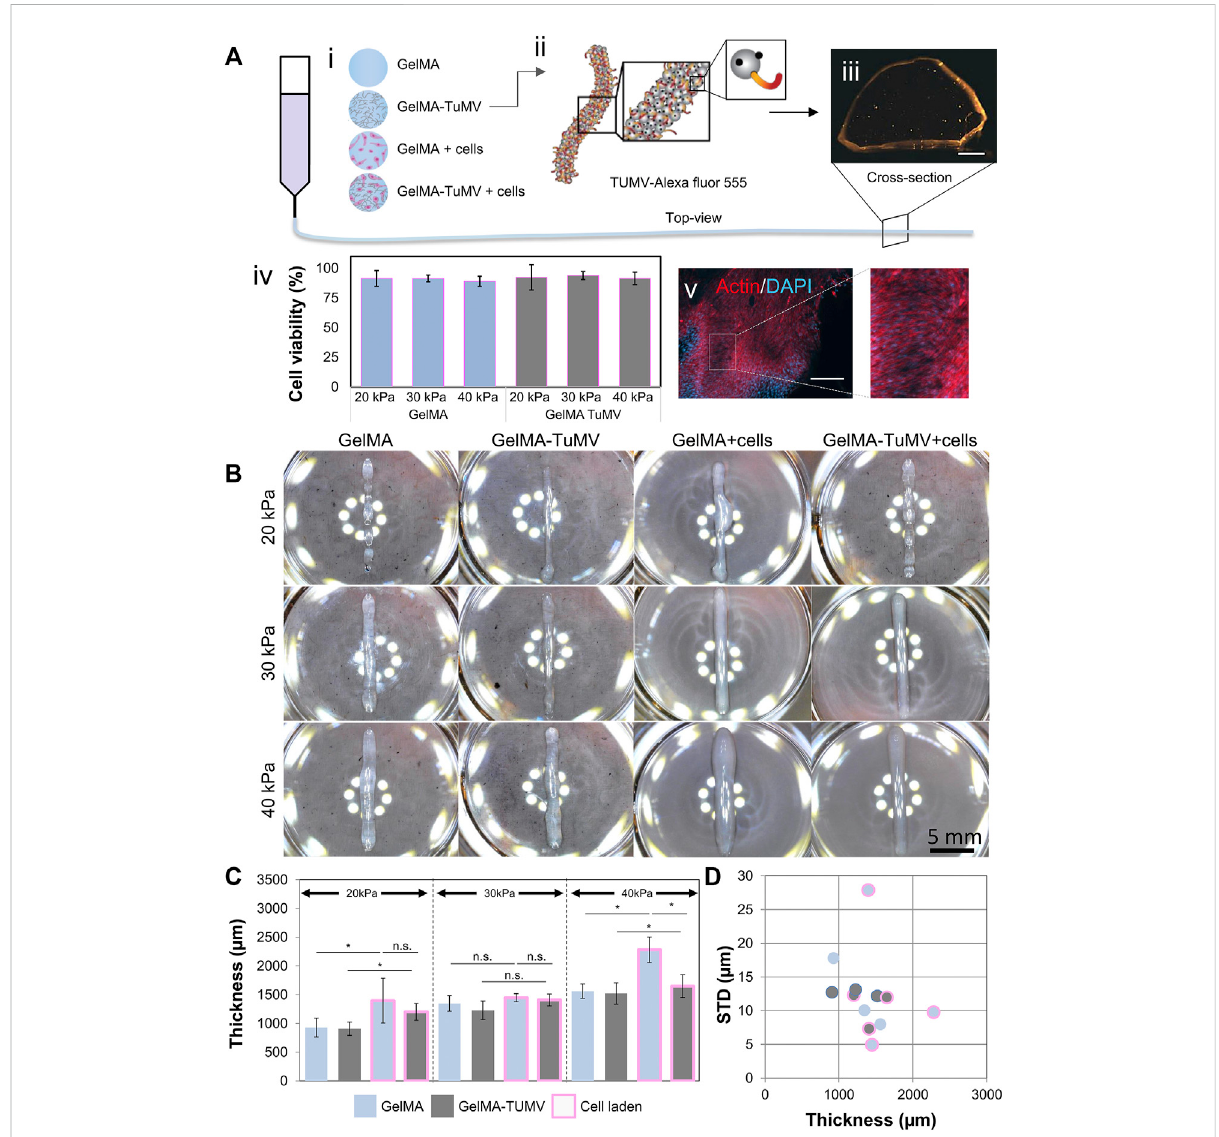
FIGURE 5 GelMA-TuMV bioprinting. (A) Hydrogels tested for extrusion bioprinting. (i) Schematic representation showing the composition of the hydrogels. (ii) Schematic representation ofthe functionalization of TuMV with Alexa Fluor 555and (iii) amicrographof thecross section ofa fi lament printed with GelMA-TuMV-Alexa Fluor 555. Scale bar = 200 μ m. (iv) Cell viability immediately after bioprinting using GelMA or GelMA-TuMV inks at different pressures, and (v) Actin/DAPI staining of fi laments printed with GelMA-TuMV loaded with C2C12 cells after 21 days of culture. Scale bar = 200 μ m. (B) Photographs of lines printed using different hydrogels. Scale bar = 5 mm. (C) Analysis of the thickness of the printed lines, and (D) the standard deviation of the thickness of fi bers, as calculated by image